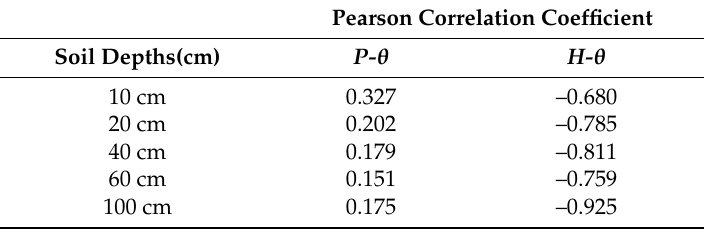
Table 3. Pearson correlation analysis between daily soil water content ( θ ) and rainfall ( P ) or water table depth ( H ) at different soil